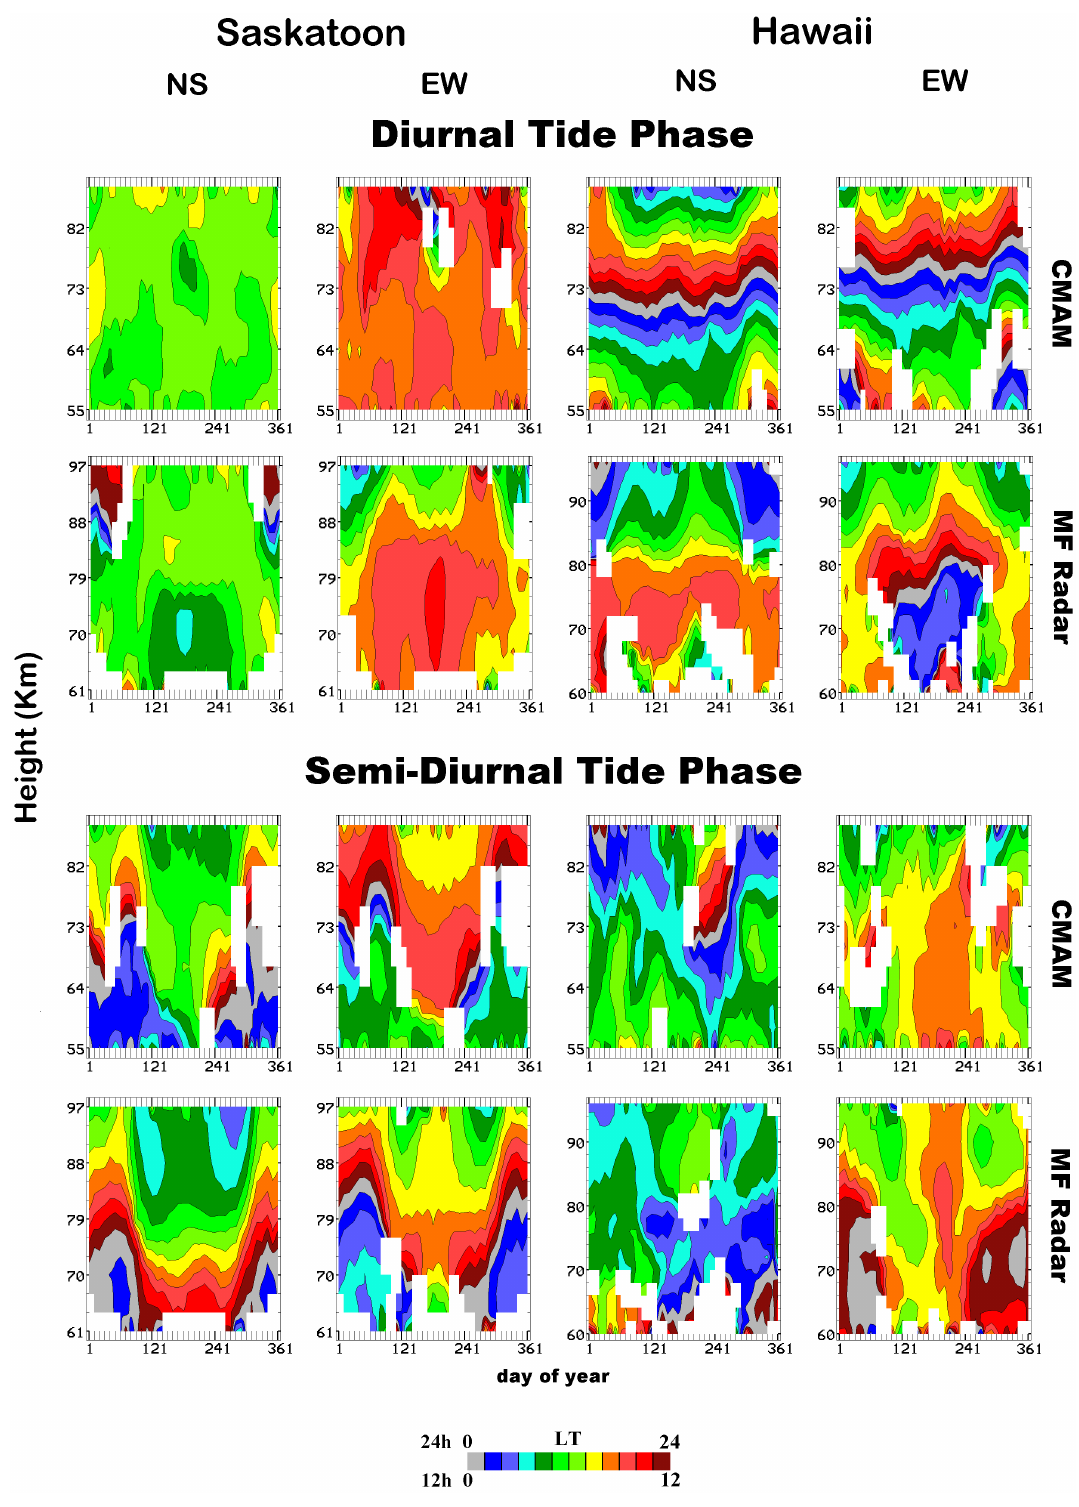
Fig. 6. Annual contour plots (height versus time) plots of diurnal and semi-diurnal tidal phases resulting from harmonic analysis of CMAM (year 31) and MF (year 2001) radar data for Saskatoon (52 ◦ N) and Hawaii (22 ◦ N), and providing 10-day resolution. Interpolation between data points employs a “bilinear patch” (Sect. 2.4). Zonal (EW) and meridional (NS) components are